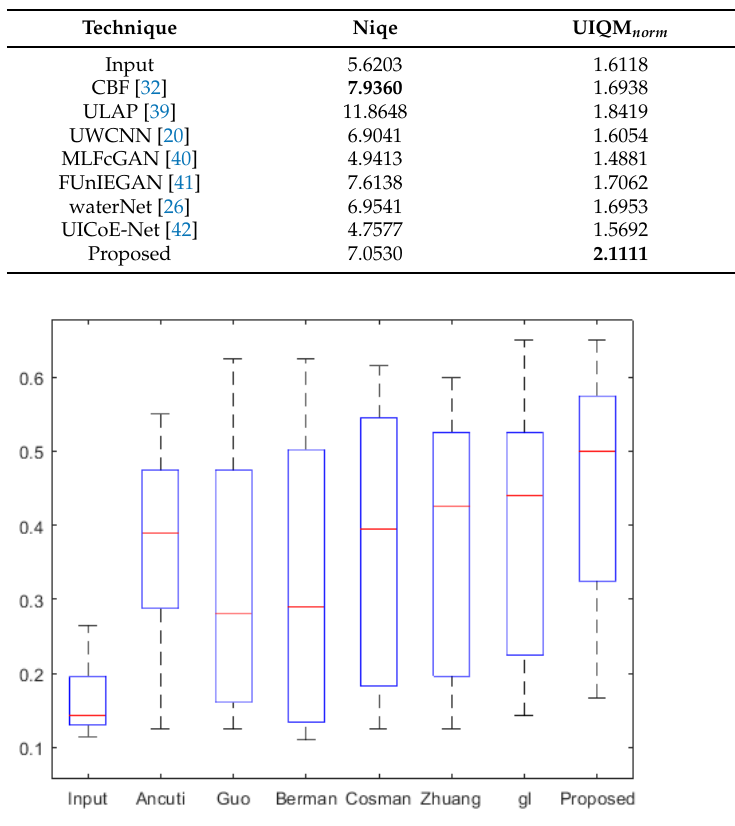
Table 6. Average niqe, UIQM norm , UCIQE comparison of different techniques whose results are partially presented in Figure 10. The best result is bold.